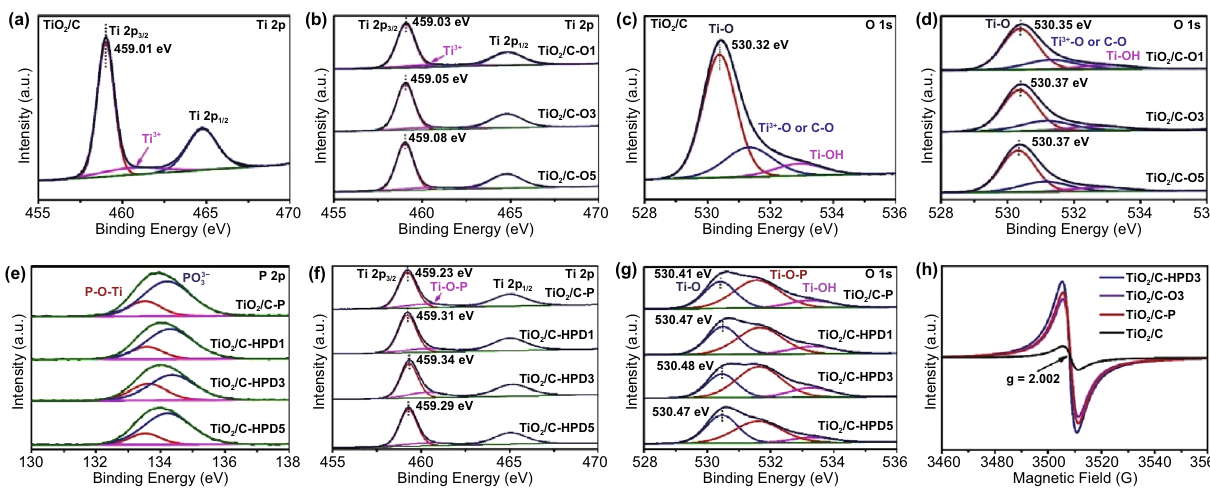
Fig. 3 High-resolution XPS spectra: a , b , f Ti 2 p , c , d , g O 1 s and e P 2 p . h Electron paramagnetic resonance (EPR) spectra of the TiO 2 /C, TiO 2 /C-P, TiO 2 /C-O3 and TiO 2